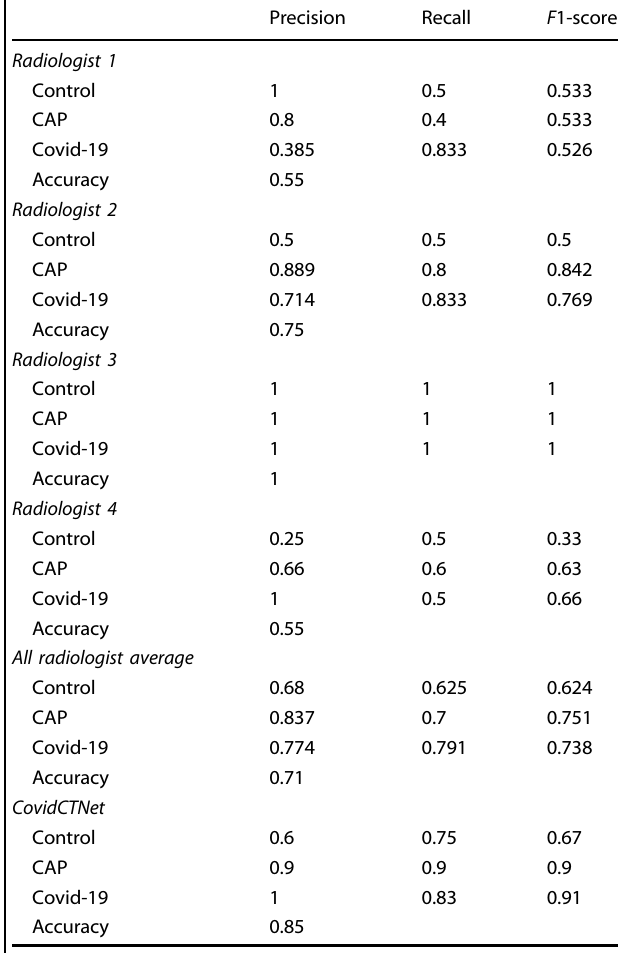
Table 3. Comparison of the accuracy of CovidCTNet versus